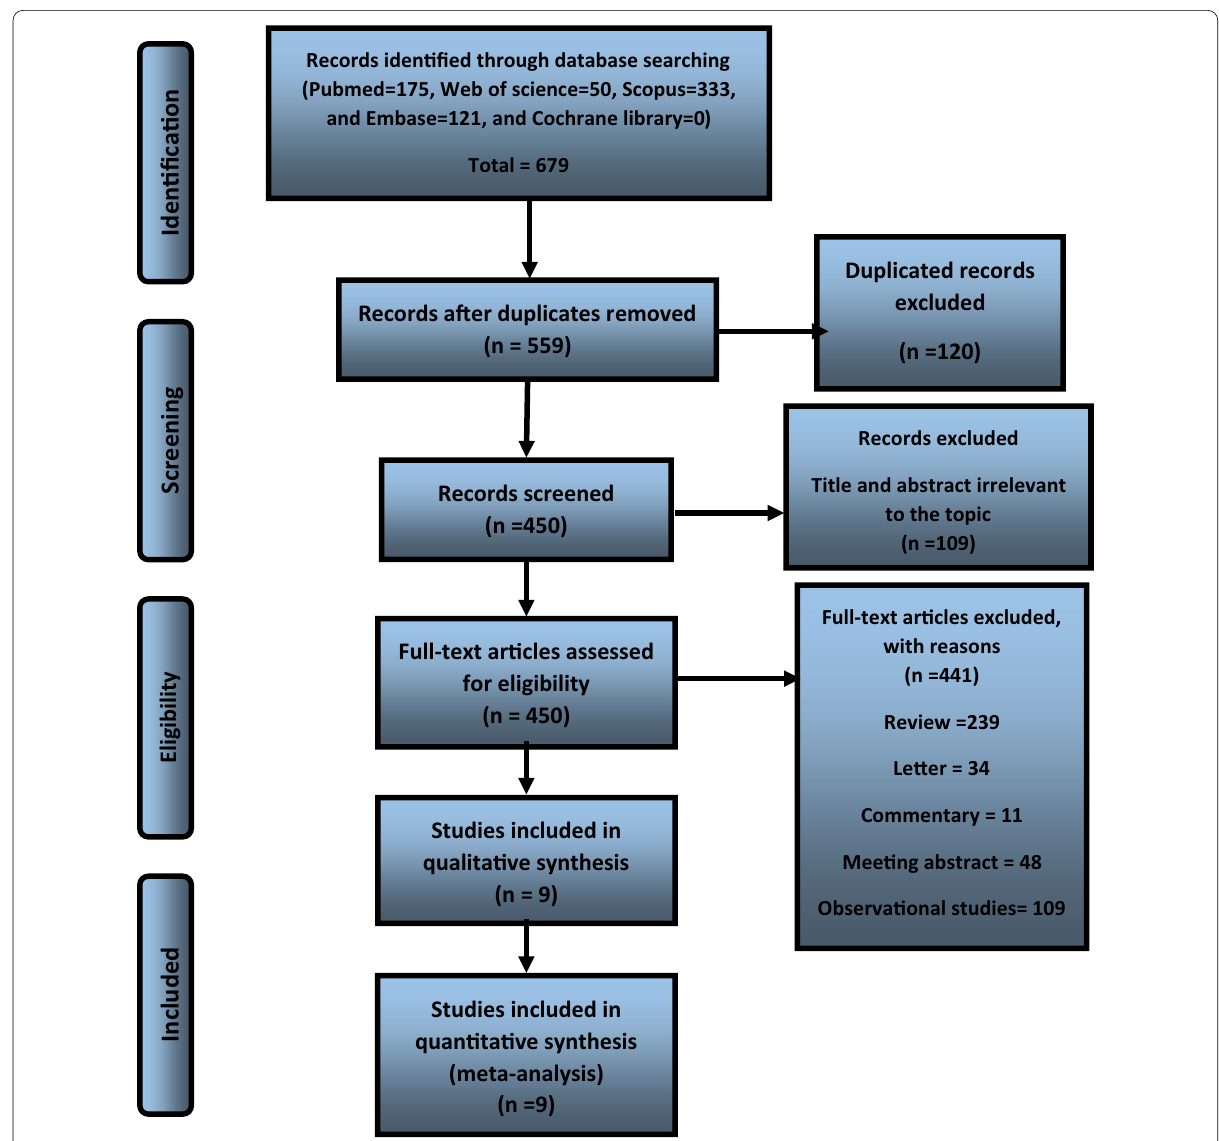
Fig. 1 Flow diagram of the selection